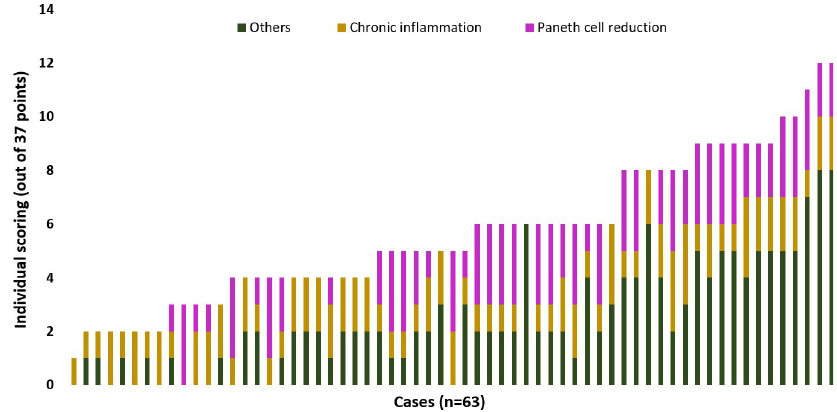
Fig 3. Histopathological scoring of individual cases (n = 63). Accumulative scores of eleven parameters graded as per the EED scoring index developed by gastrointestinal pathologists with input from members of the EED Biopsy Initiative Consortium. Out of 63 cases, two biopsy specimens scored 12 out of 37 while one scored 1 out of 37. Chronic inflammation and reduction in Paneth cell density were the most consistent features.